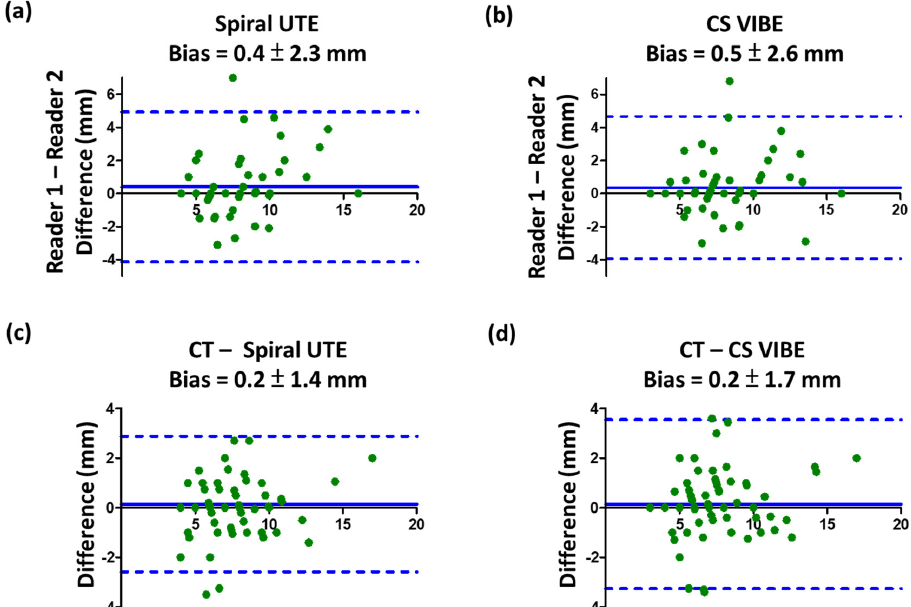
Figure 5. Bland–Altman plots depicting reliability and agreement of CT and MRI nodule measure- ments. Inter-reader reliability for the nodule diameter measurements showed a small inter-reader bias of less than 0.5 mm for ( a ) spiral UTE and ( b ) CS-VIBE. MRI modalities by ( c ) spiral UTE and ( d ) CS-VIBE images minimally underestimated the nodule size by 0.2 mm, compared to the reference CT. Abbreviations: MR: magnetic resonance; VIBE: volumetric interpolated breath-hold examination; CS: compressed